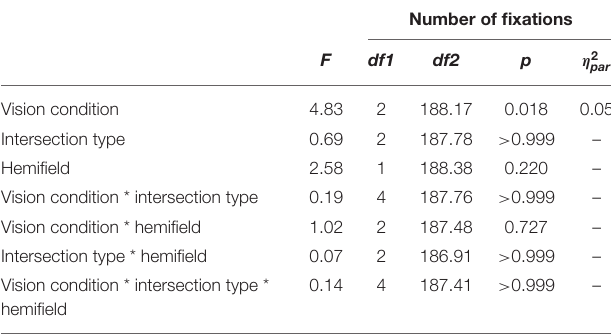
TABLE 6 | Results of the mixed-model ANOVA for fixation duration (Bonferroni corrected for additional analysis on number of fixations, see Table 5 ).